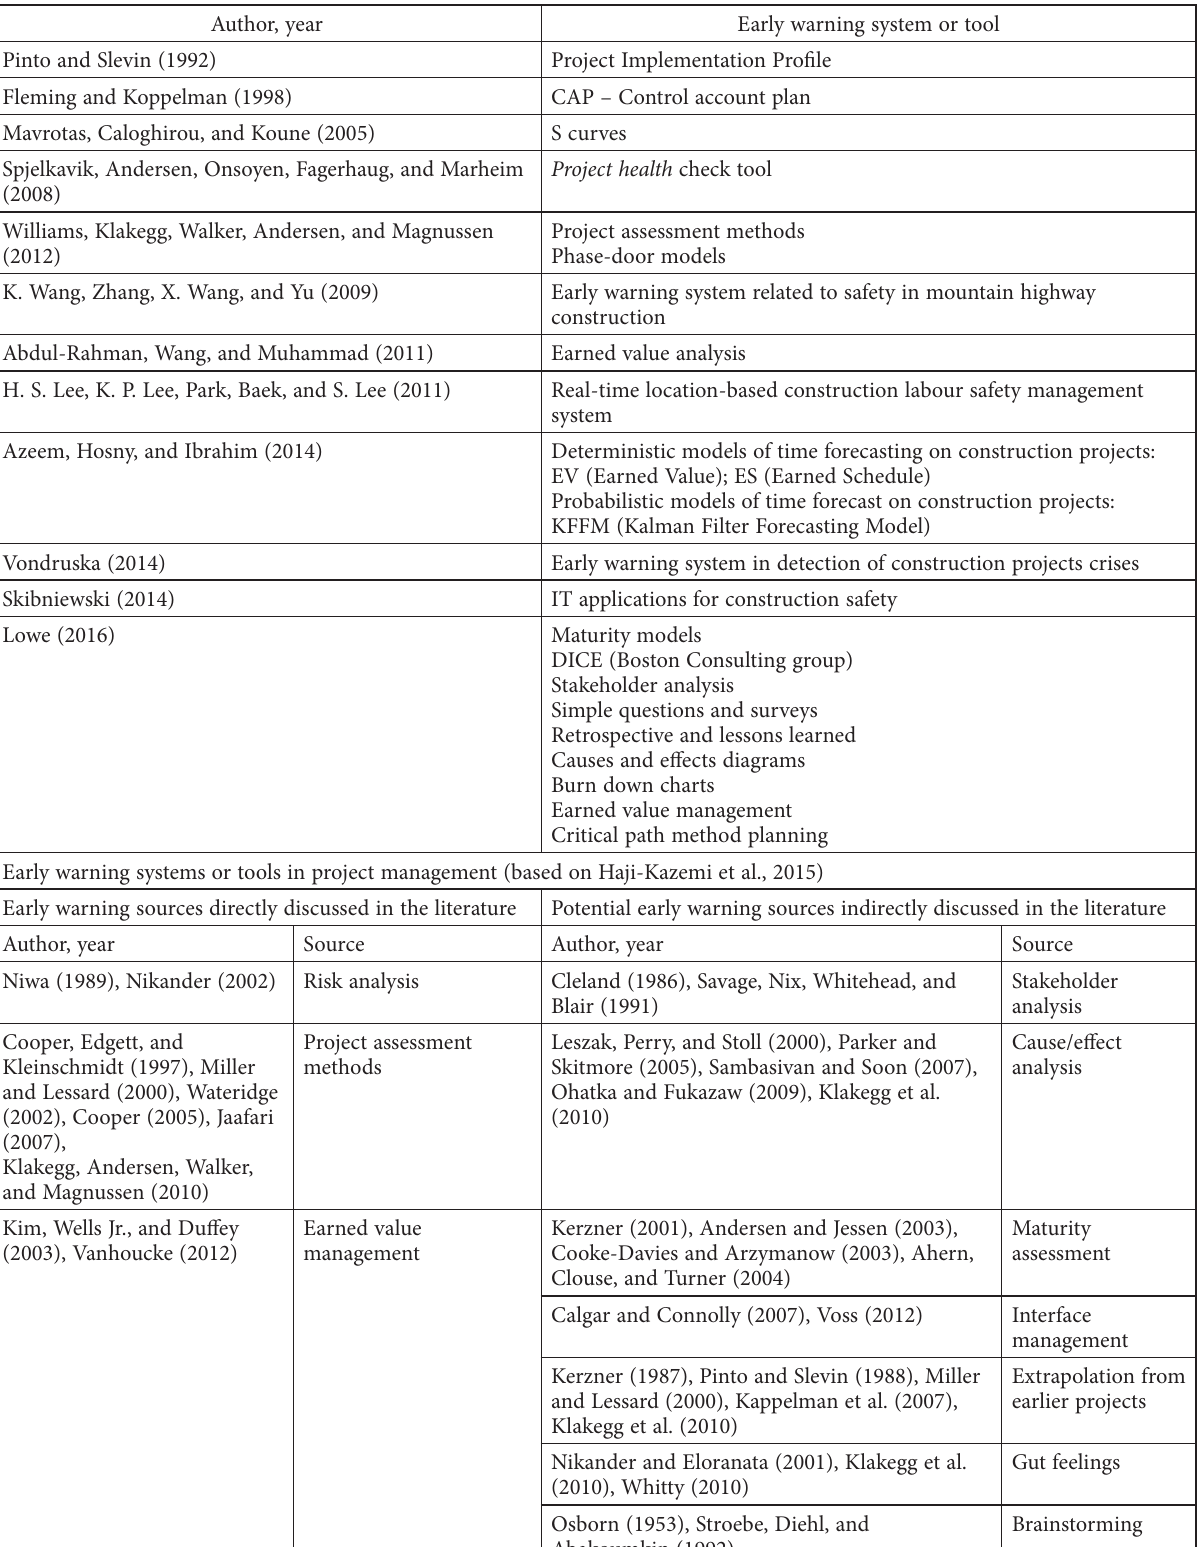
Table 1. Early warning systems or tools in project